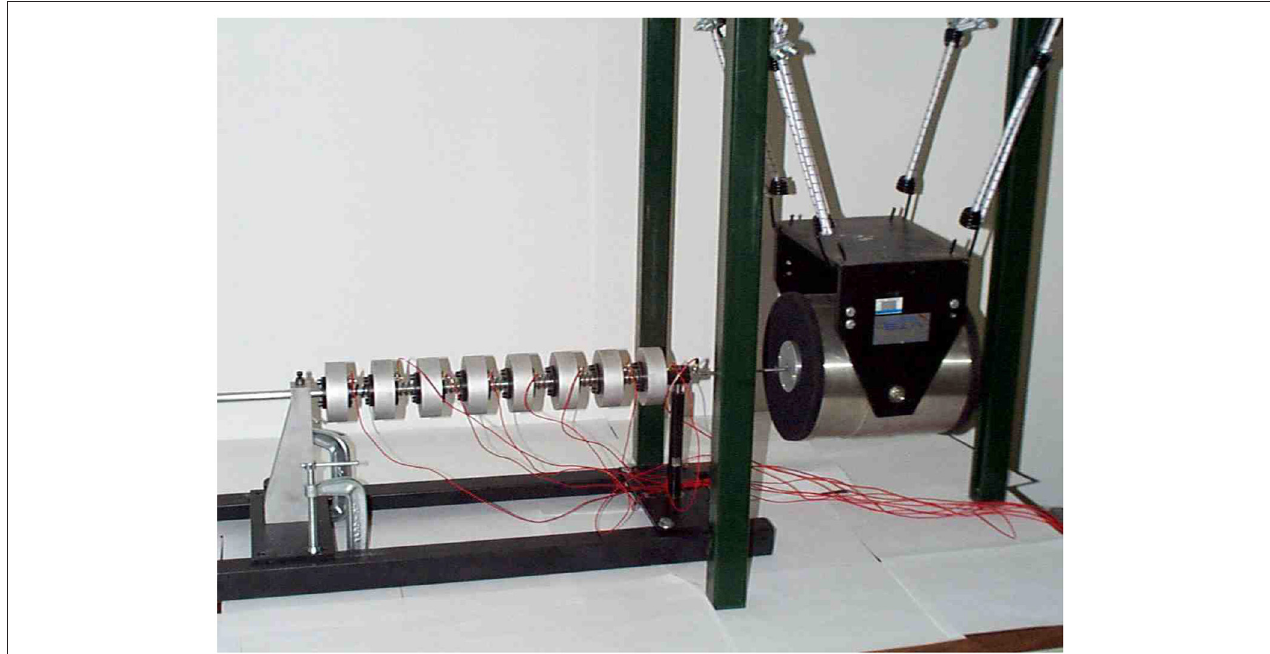
FIGURE 3 | Eight degree-of-freedom experimental rig which is the basis of the form case study here.